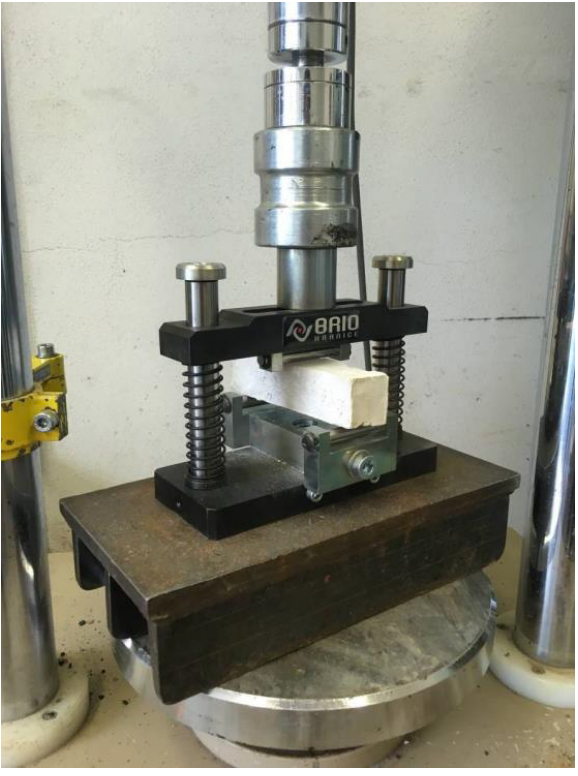
Figure 9. Three point flexural test technique [8].